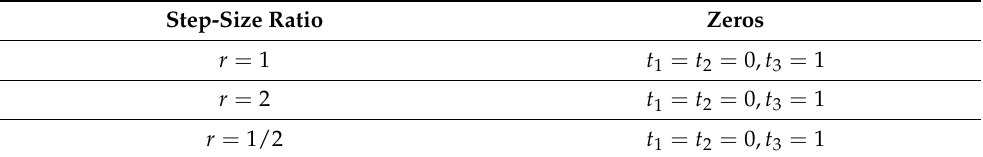
Table 3. Zeros for the VSHBM.